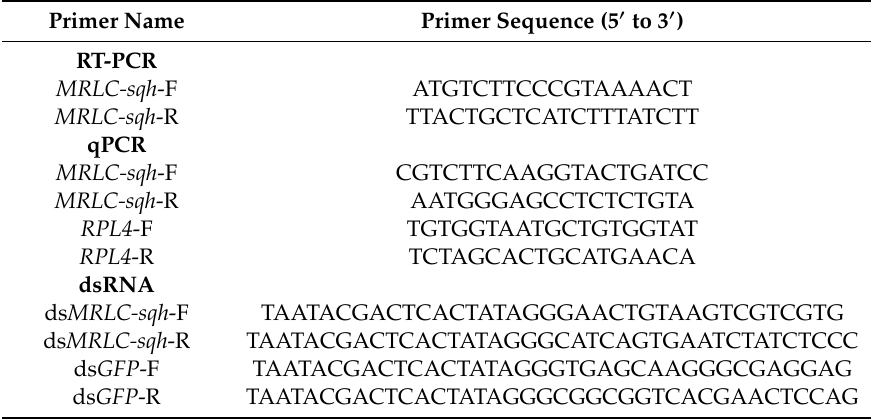
Table 1. Primers used in this